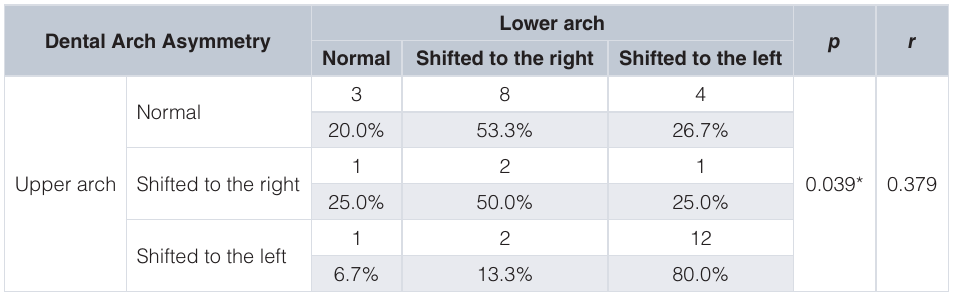
Statistically significant difference ( p